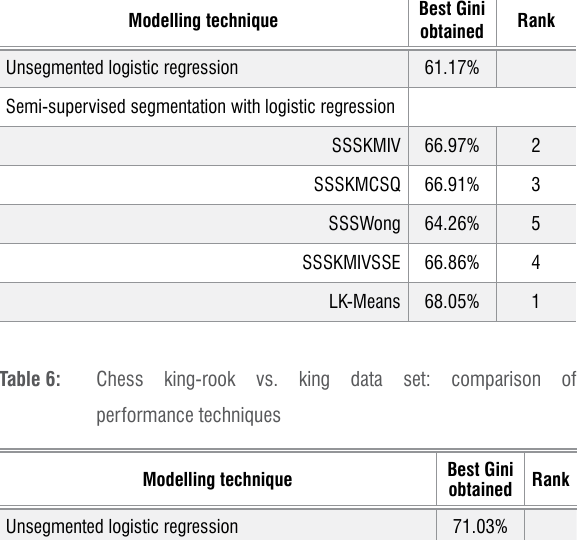
Wine quality data set: comparison of performance of techniques Modelling technique